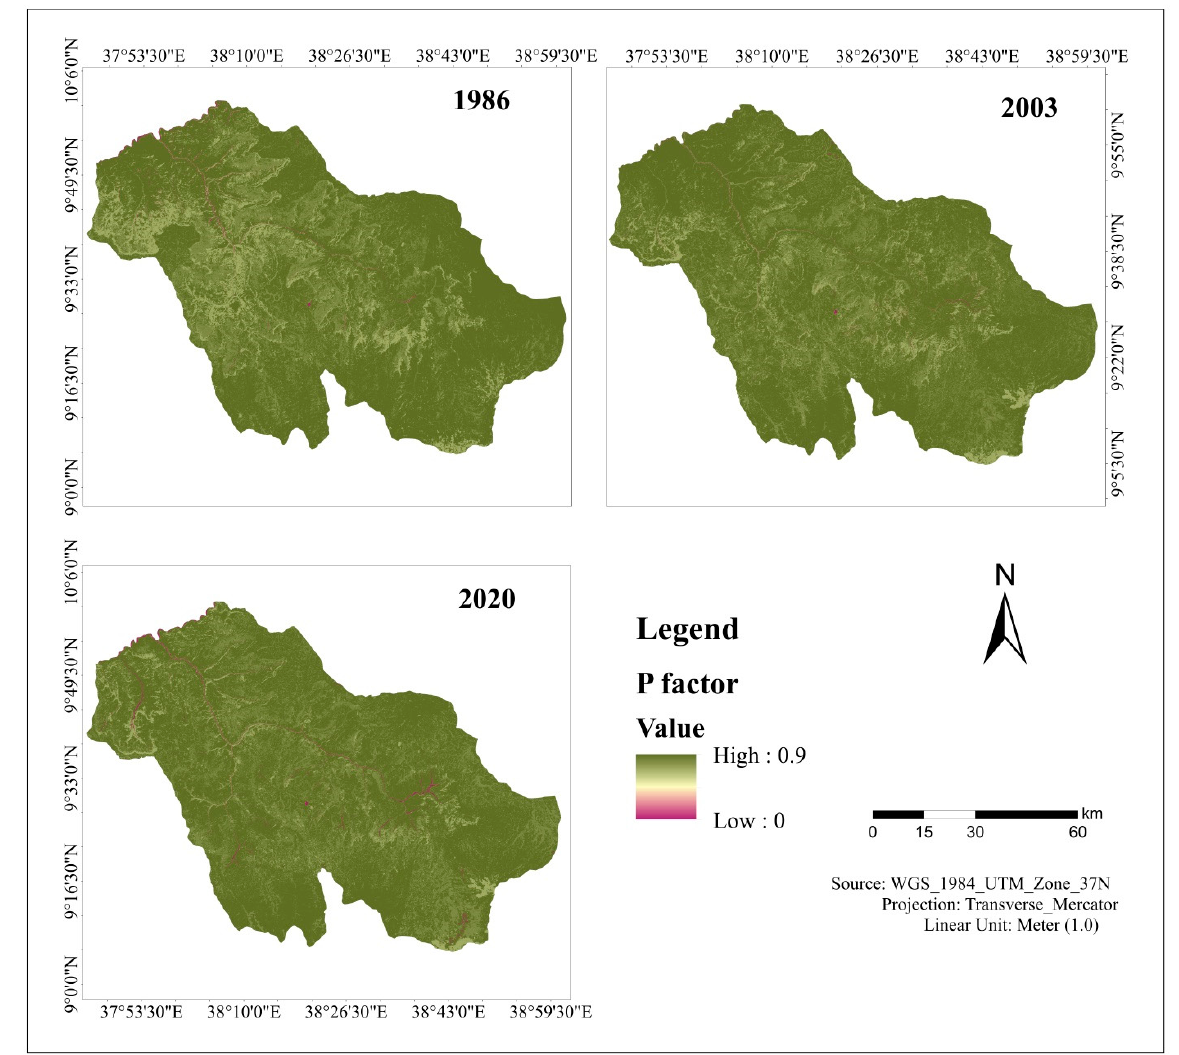
Figure 8. P-factor map of the study sub-basin for 1986, 2003, and 2020.